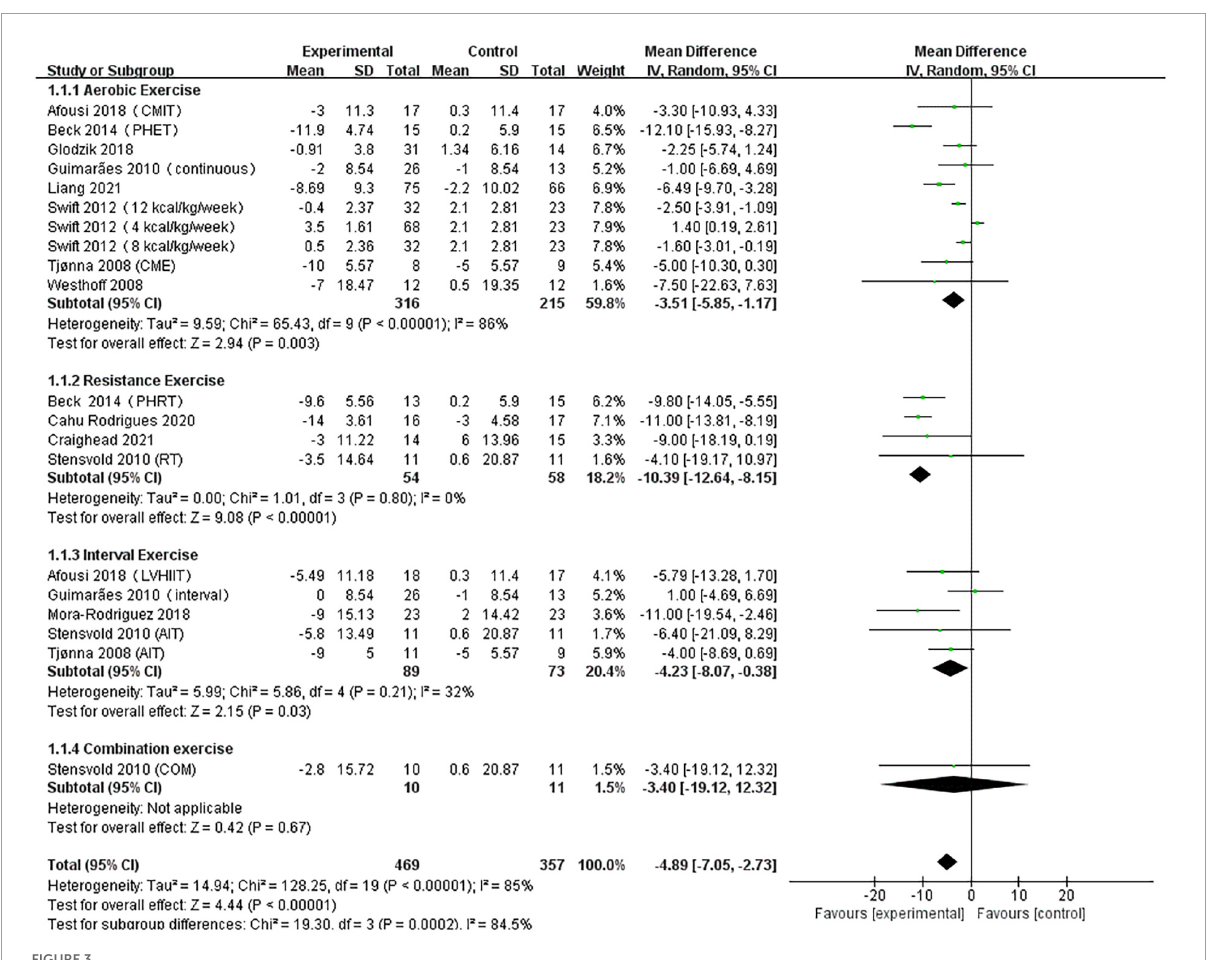
FIGURE3 Forest plot of postintervention SBP-value comparison between exercise and control groups. SD, standard deviation; Std, standardized; IV, inverse variance; CI, confidence interval; CME, continuous moderate exercise; LVHIIT, low-volume high-intensity interval